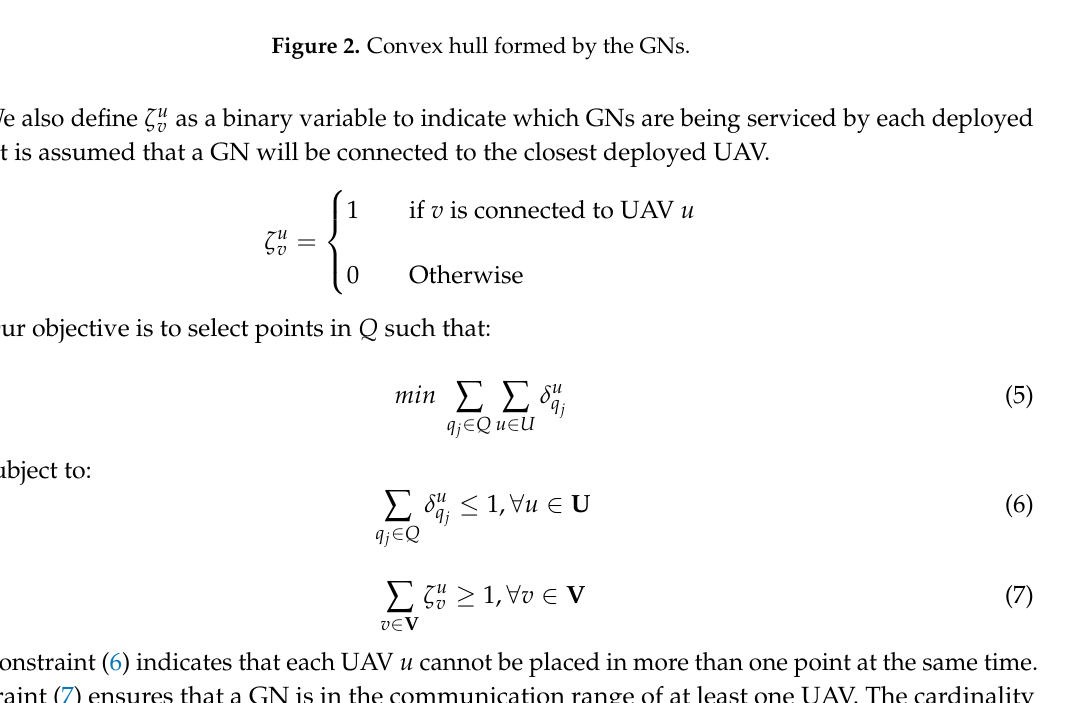
Figure 2. Convex hull formed by the